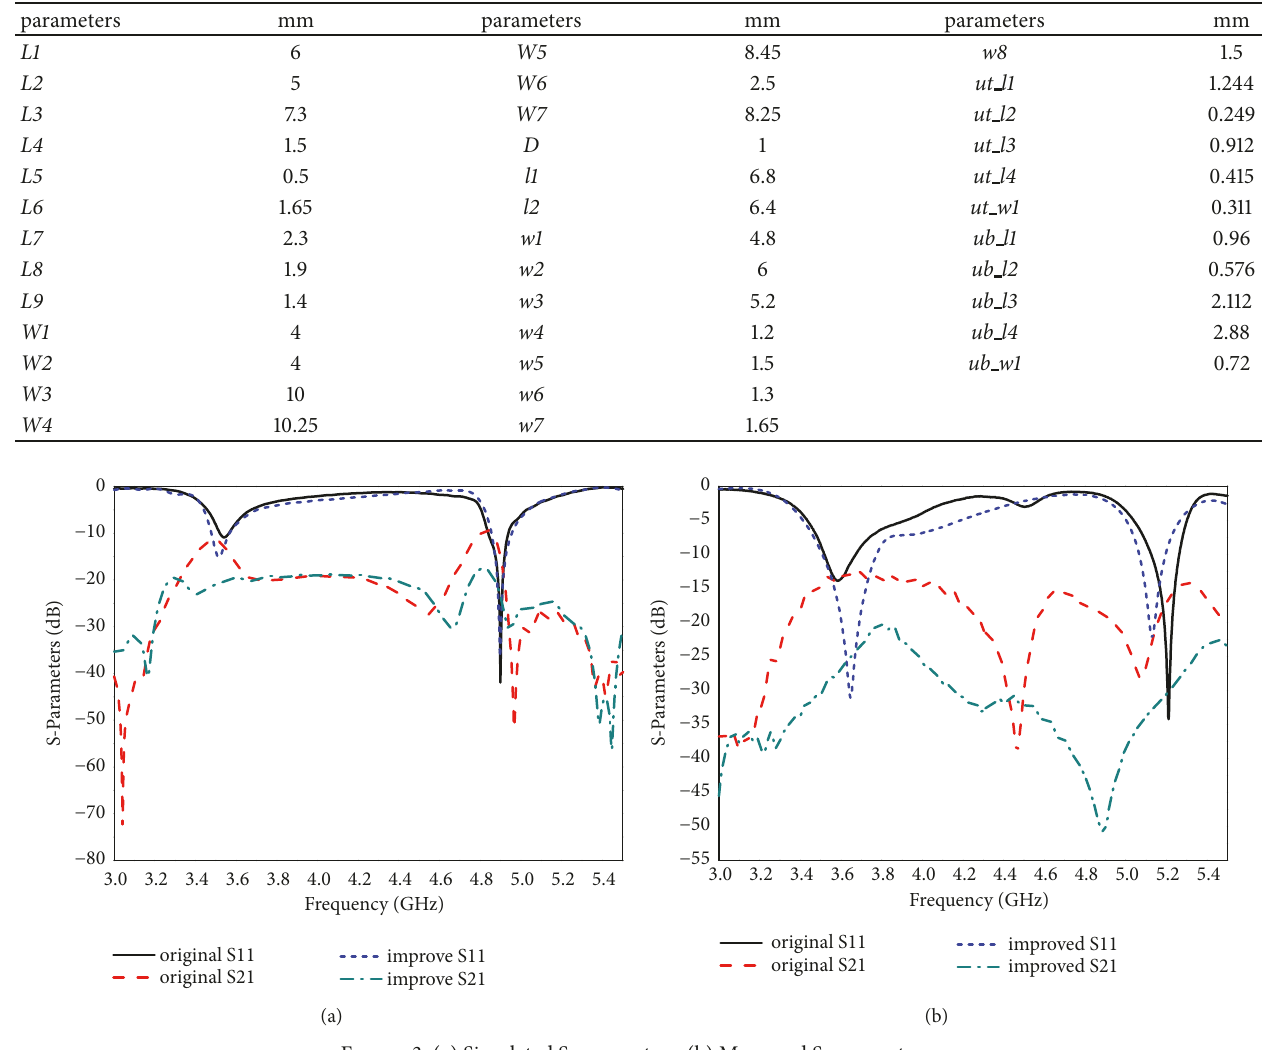
Table 1: The specific parameters of MIMO antenna.